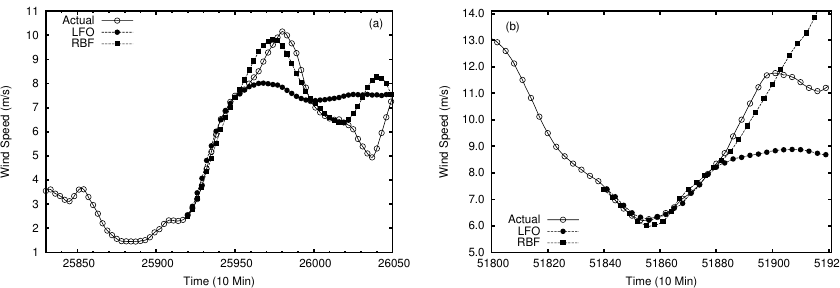
Figure 8. Comparison of predicted values with the actual values for LFO and RBF. The symbols are plotted only at every 30min for legibility. (a) Latitude: 42.31925 ◦ N, longitude: 98.60197 ◦ W m = 5, τ = 8; (b) latitude: 43.51076 ◦ N, longitude: 99.47652 ◦ W, m = 12, τ = 2. 6